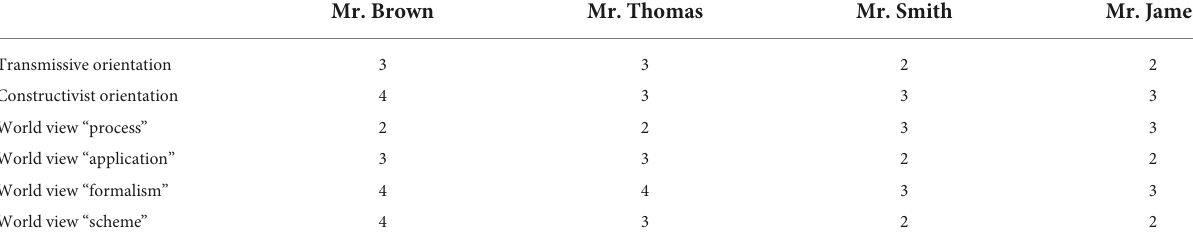
TABLE 3 Results of beliefs about students’